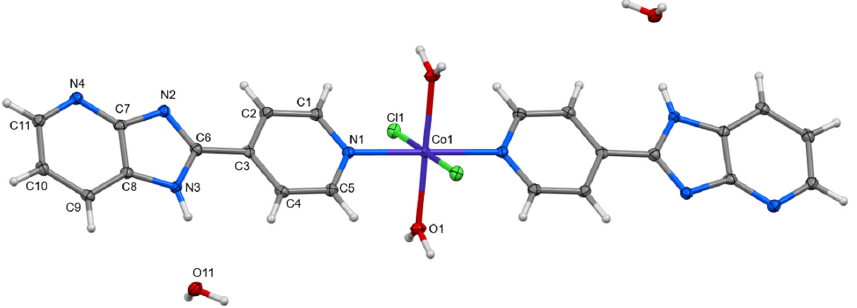
Figure 5. Molecular structure of C1 . Table 3. Structural data of the coordination polyhedron in C1 .